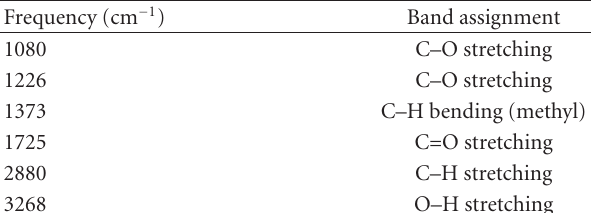
Table 5: Prominent peaks obtained from reflectance FTIR spec- troscopy.